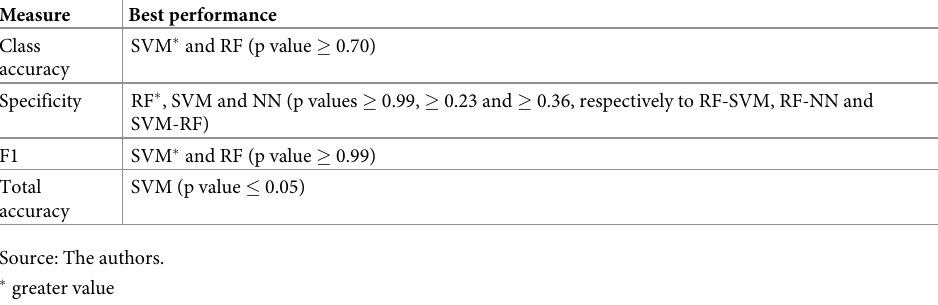
Table 6. Comparison between the approaches according to the accuracy, specificity and F1 in the evaluation phase —results of Tukey’s multiple comparisons